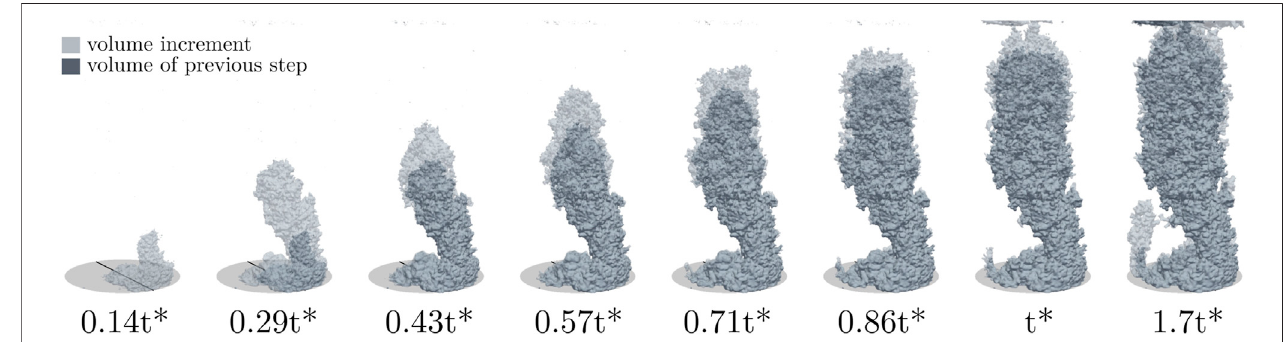
FIGURE 4 | X-ray tomography reconstruction of the fi nger pattern for a low capillary number (Ca = − 7.67, same as Figure 3C ). The slow process enables to capture the development of capillary fi ngering in 3D.